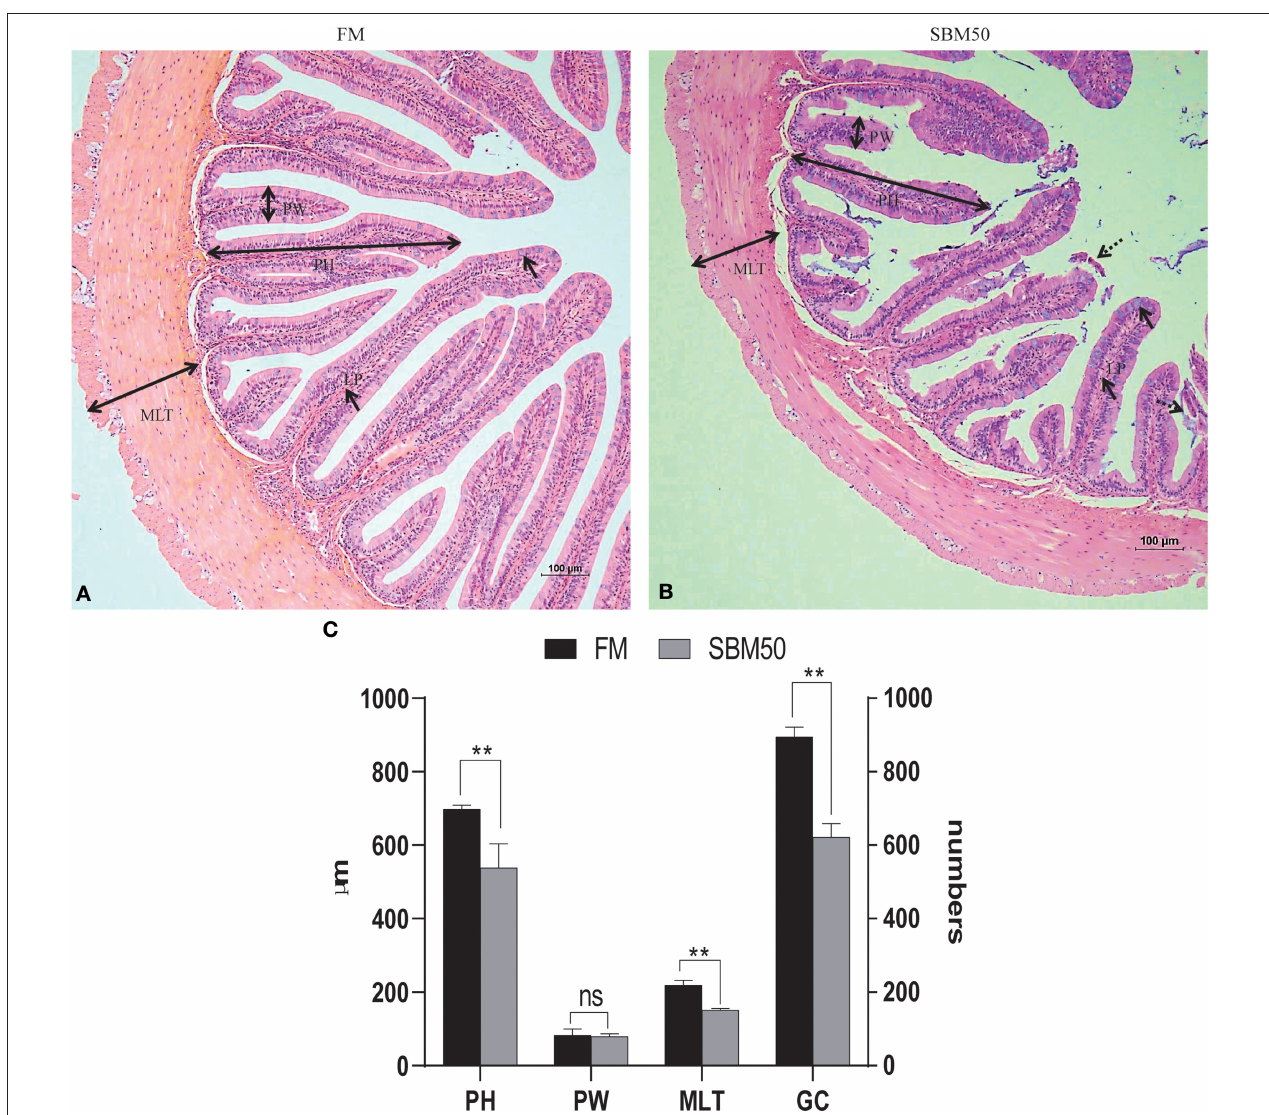
FIGURE 1 | Histological analysis of the distal intestine in hybrid grouper. (A) HE staining of the FM group (100 × ). (B) HE staining of the SBM50 group (100 × ). (C) Intestinal morphometric measurements between FM and SBM50 groups. Mean ± S.E.M ( n = 10). LP, lamina propria; PH, Plica height; PW, plica width; MLT, muscular